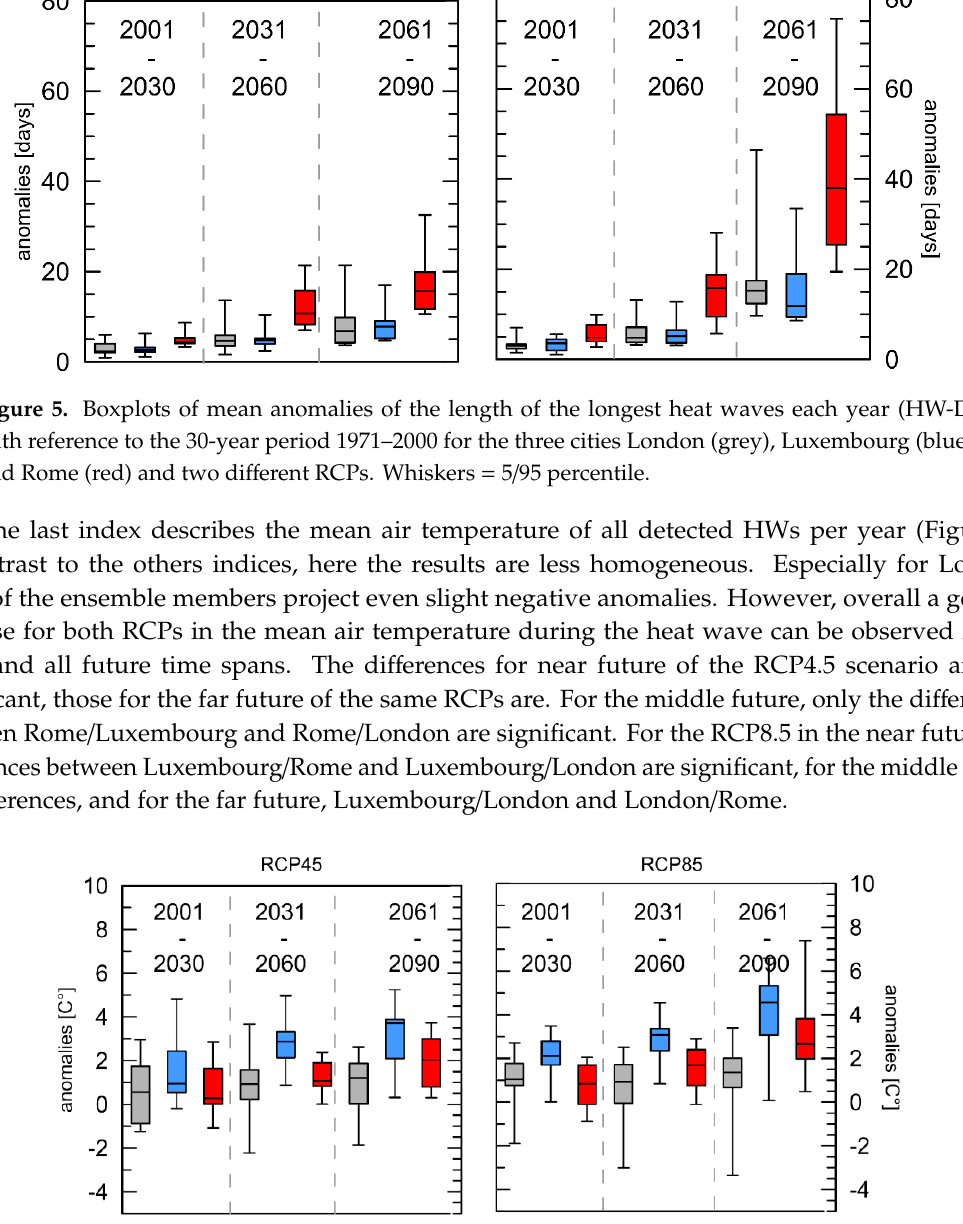
Figure 6. Boxplots of mean anomalies of the mean temperature of all heat waves per year (HW-M) with reference to the 30-year period 1971–2000 for the three cities London (grey), Luxembourg (blue), and Rome (red) and two different RCPs. Whiskers = 5/95 percentile.